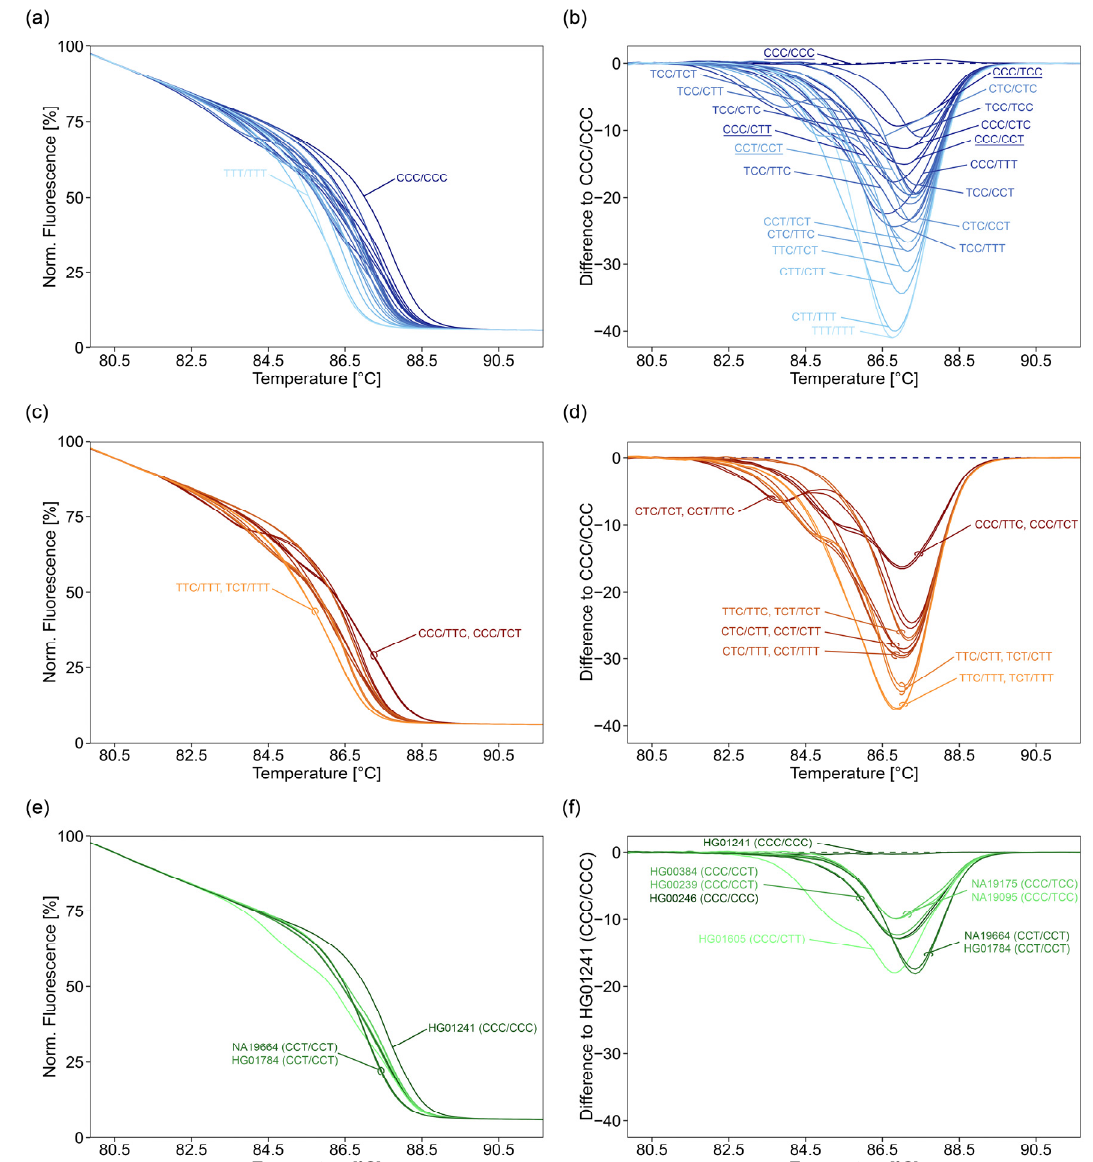
Figure 5. Genotype discrimination of the 3 SNPs assay by HRM analysis. Data are shown as ( a , c , e ) normalized melting curves and ( b , d , f ) difference to the triple-homozygous control CCC/CCC of the respective sample set (dashed line). ( a , b ) 22 diploid oligonucleotide controls that could be distinguished manually included all 5 variant combinations (underlined) present in the NHGRI Sample Repository for Human Genetic Research. ( c , d ) 14 diploid oligonucleotide controls grouped in 7 pairs of identical melting curves. ( e , f ) The melting curve of NHGRI sample HG00246, indicated as CCC/CCC in the Ensembl data base, grouped together with those of HG00384 (CCC/CCT) and HG00239 (CCC/CCT). Data displayed in one plot originate from the same PCR-HRM run. For clarity reasons, the melting curve of one PCR replicate is shown. Half of the double-heterozygous combinations had two individual melting transi- tions, with a difference in Tm of about 2.2–2.4 ◦ C. The variant combinations TTC/CTT and TCT/CTT resulted in derivative curves with identical Tms and peak height ratios (Figure S4c). Double-heterozygous combinations having either CCC or TTT in one DNA strand yielded three melting transitions. Three peak maxima were obtained for the dis- tinguishable variant combinations CCC/CTT and TCC/TTT. Identical melting curves containing two peak maxima and one shoulder were obtained for the pairs CCC/TTC and CCC/TCT, and CTC/TTT and